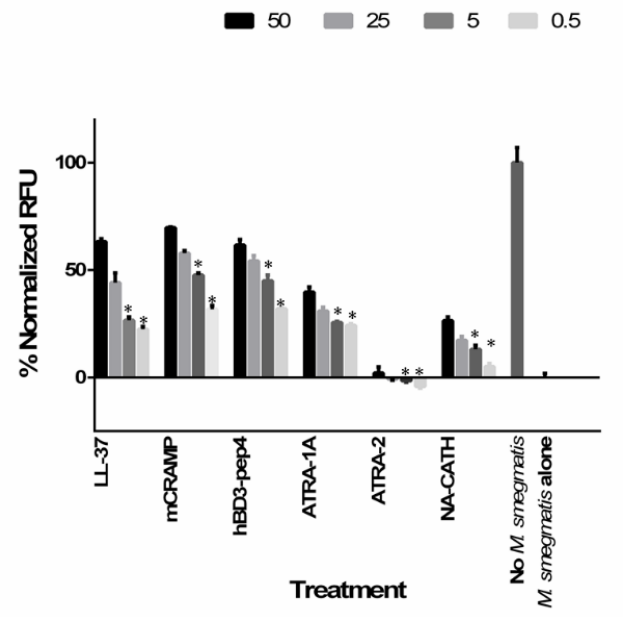
Figure 1. Membrane depolarization activity by LL-37, mCRAMP, hBD3-Pep4,